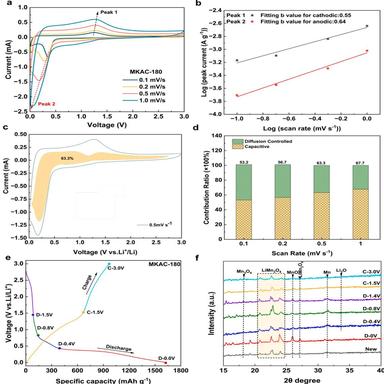
(a) CV curves of the MKAC-180 anode at different scan rates, (b) Relationship between the peak currents and potential sweep rates of the MKAC-180 anode, (c) CV curve and capacitive contribution ratio for scan rate at 0.5 mV⋅s − 1 , (d) Relative contributions of capacitance and diffusion-controlled charge storage at different scan rates, (e)The first charge–discharge curve and (f) Ex-situ XRD patterns at various potentials during the charge discharge process of the MKAC-180 anode.